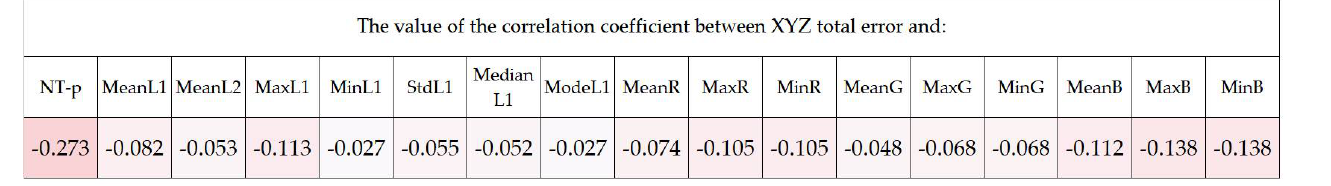
of tie-points in the F-points’ vicinity increases the XYZ total error.